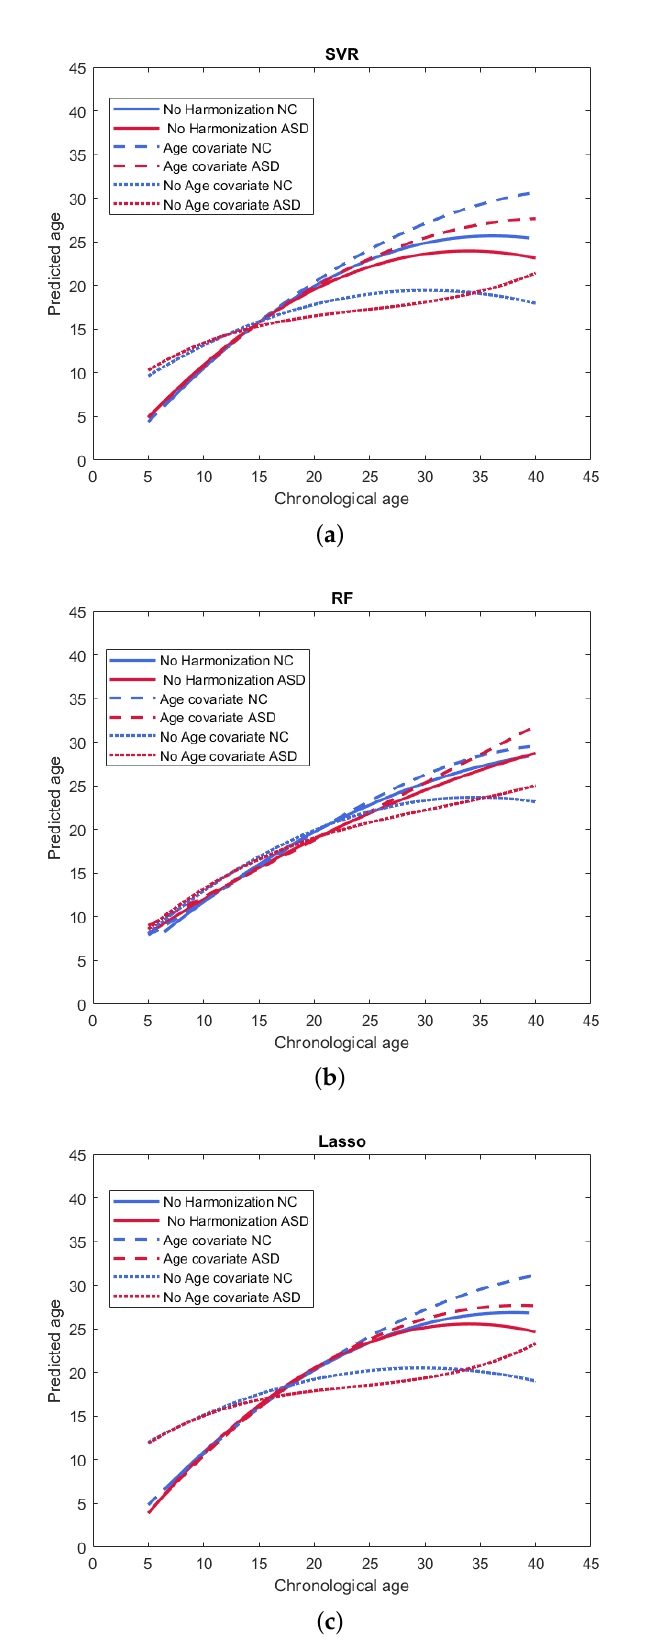
Figure 3. Best-fitting models of chronological age-predicted age resulting from ( a ) SVR; ( b ) RF; ( c ) Lasso, for the three harmonization